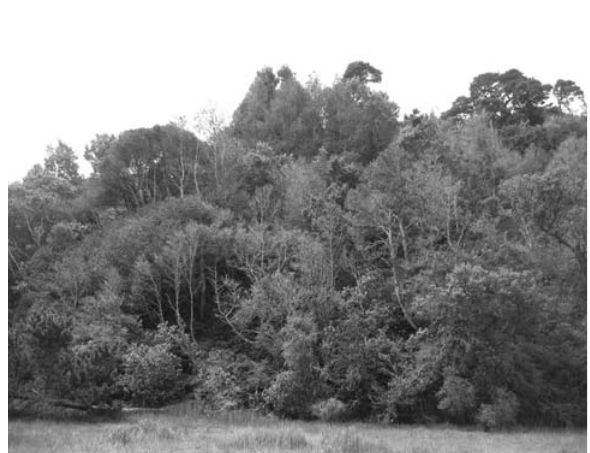
Fig. 1. Sudden oak death, an exotic disease intro- duced in California through ornamental plants is reshaping this forest by killing the majority of tanoaks ( Lithocarpus densi fl orus